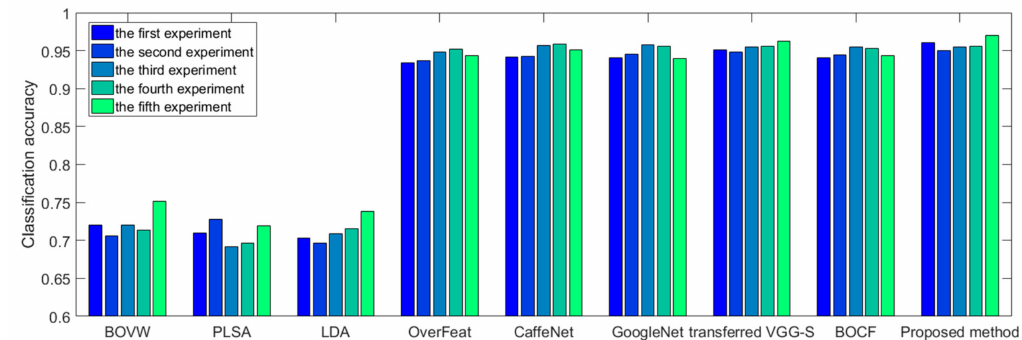
Figure 11. The classification accuracy of five experiments on the proposed method and the state-of-the-art methods in the WHU-RS